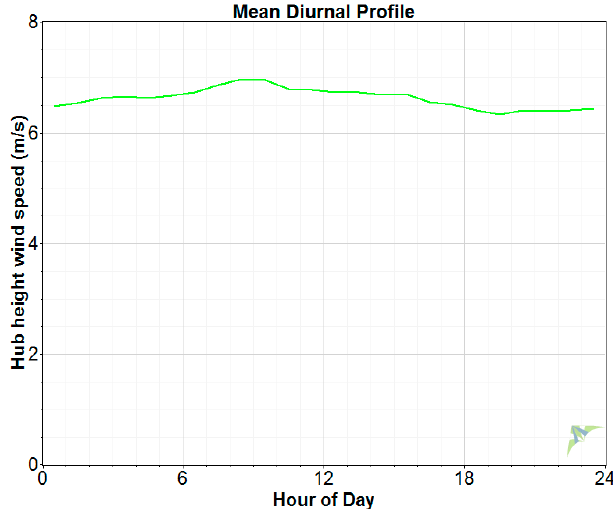
Figure 7. Mean diurnal profile of 12 months.